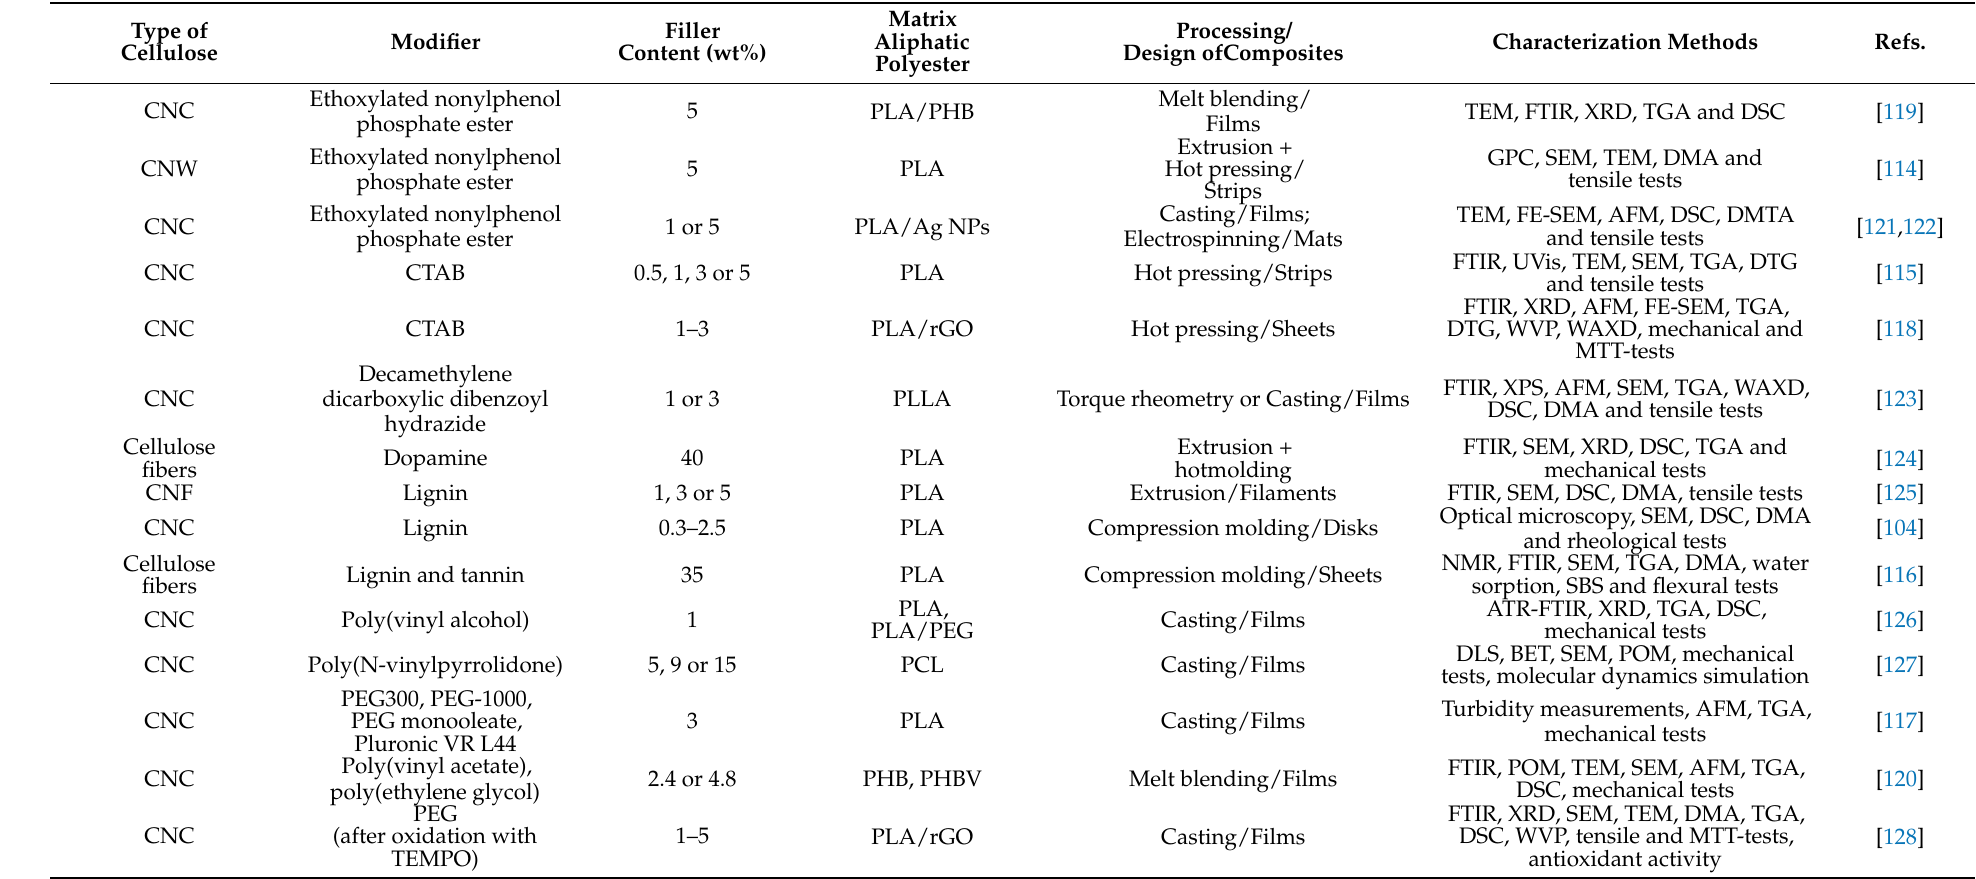
Table 3. Selected studies on modification of cellulose micro- and nanomaterials via adsorption of small molecules and polymers. Type of